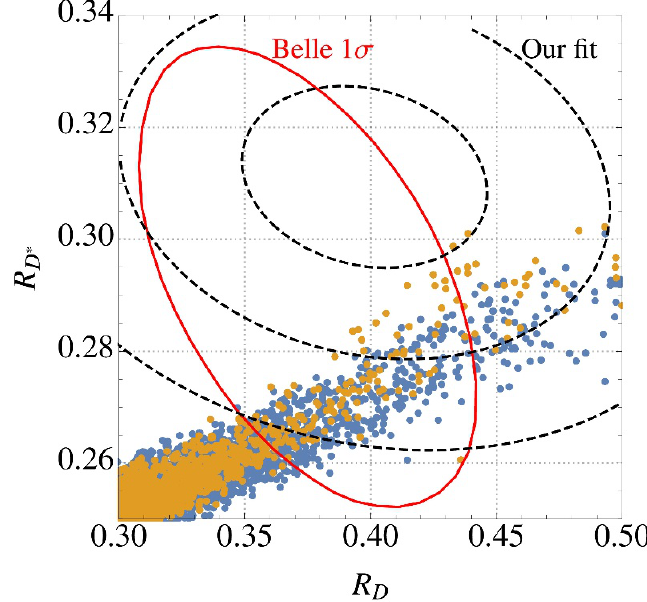
Figure 12. The results of scan II presented as a scatter plot of R keep C SM-like, while blue points show a > 1% deviation in C LL dashed black ellipses represent the 1, 2 and 3 (cid:27) contours from our (cid:12)t with an assumed correlation (cid:26) = (cid:0) 0 : 2, while the solid red curve indicates the 1 (cid:27) allowed region implied by the Belle measurement from ref. [26]. The anomalies in b ! c(cid:28)(cid:23) can be accommodated in this model, although even small, non-zero values for the x cause tension with limits from B ! K(cid:23)(cid:23) and measurements of B i 2 mixing, causing few points to stray into the 1 (cid:27) region of our (cid:12)t. involved are unimportant for b ! c(cid:28)(cid:23) . Saturating both x